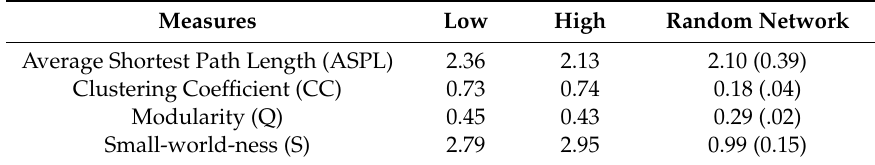
Table 3. Empirical and random measures of the DT semantic